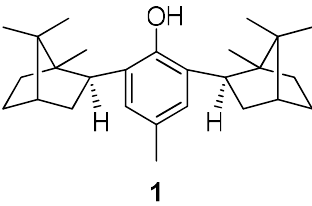
Figure 1. Structure of 2,6-diisobornyl-4-methylphenol 1 .